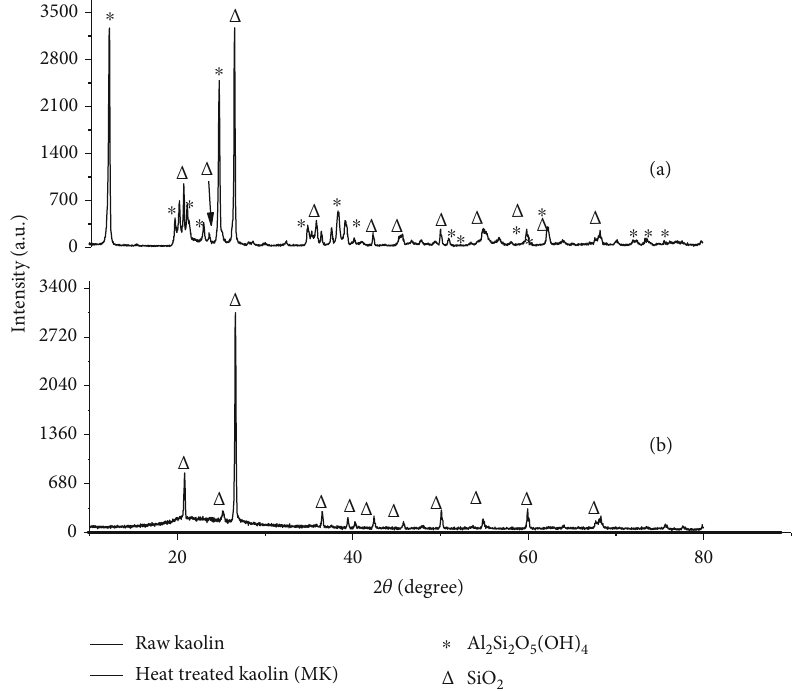
Figure 5: XRD spectra of (a) raw kaolin and (b) heat-treated kaolin